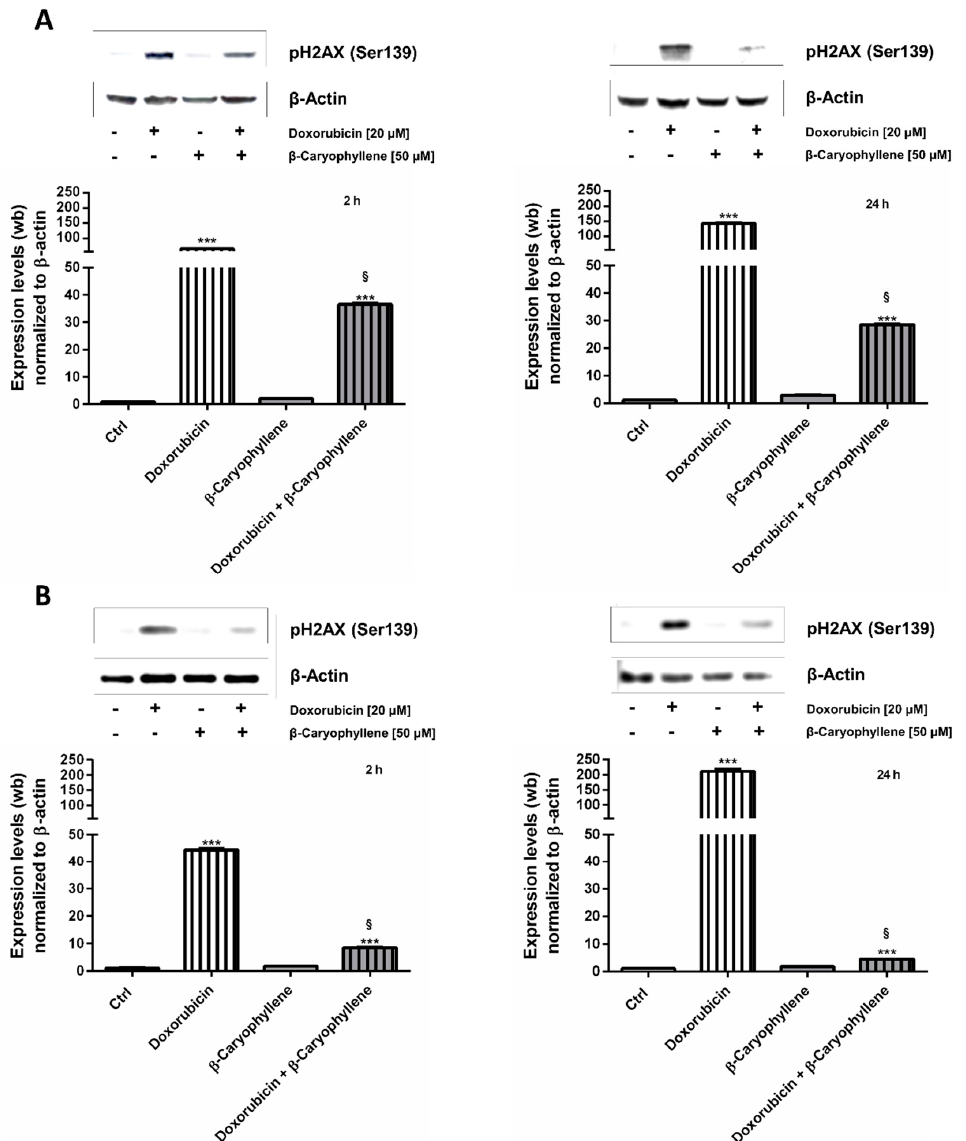
Figure 6. Effect of the natural sesquiterpene β -caryophyllene (50 µM), doxorubicin (20 µM) and their combination compared the control on the levels of phosphorylated H2AX at Ser139 residue ( γ H2AX) in Mz-ChA-1 cholangiocarcinoma cells ( A ) and H69 noncancerous cholangiocytes ( B ). The cells were treated for 2 h and 24 h, then the pellets were harvested for the western blotting analysis. For each experimental condition, the densitometric bar graph (data expressed as mean ± standard error) obtained from at least two independent replicates and a representative western blotting image, showing the expression levels of γ H2AX and β -actin used as protein loading control, were displayed. *** p < 0.001 (one-way ANOVA followed by Dunnett’s multiple comparison post-test), significantly higher than the vehicle control (basal level). § p < 0.001 (t-Student test), significantly lower than doxorubicin.